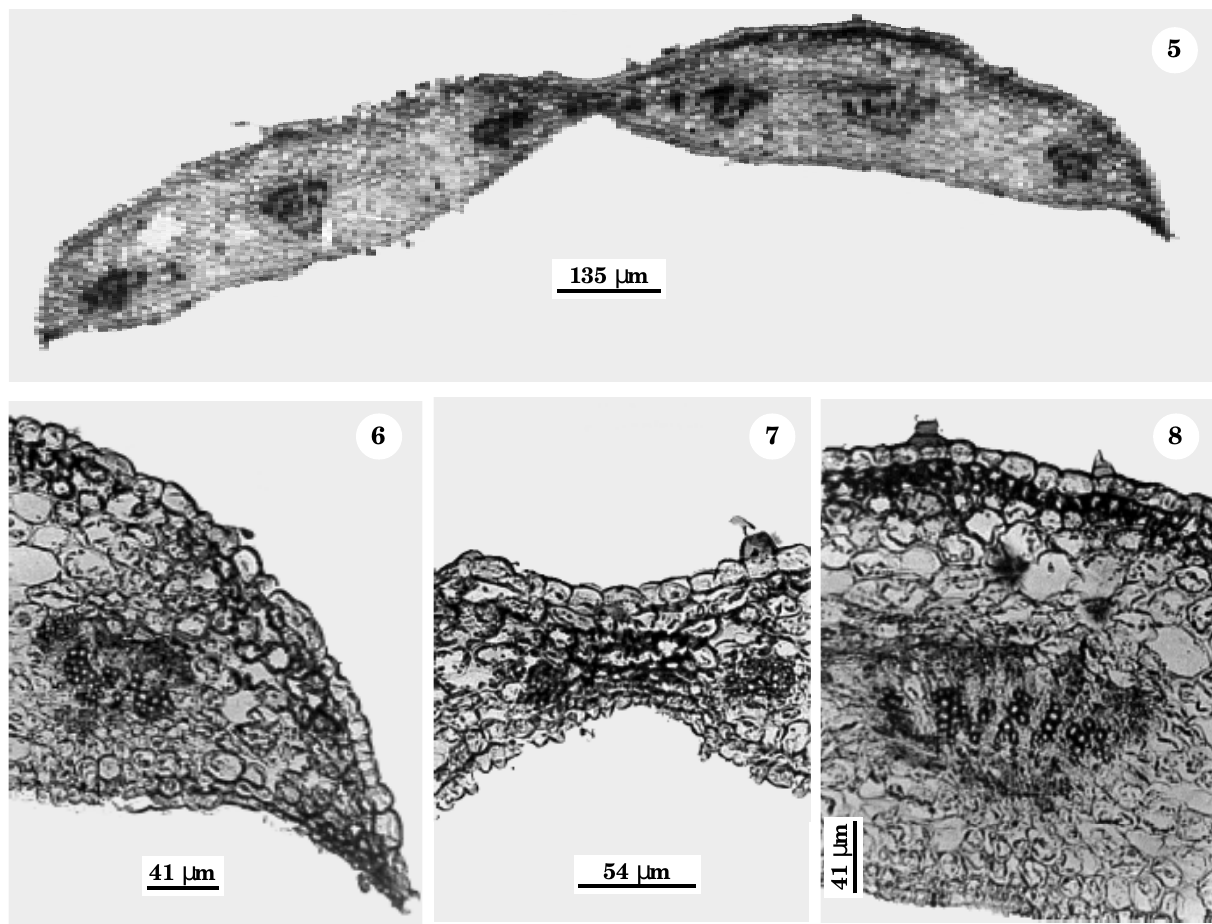
Fig. 5-8. Cross sections of sepal of Marmande tomato flower infected with TMV-M showing the connection of 2 sepals (5), magnified part of lateral vein (6), region of connection or isthmus (7), magnified part of midvein